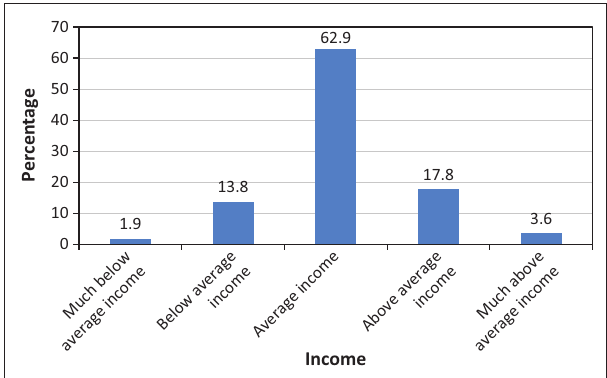
FIGURE 1: Percentage of individuals covered by health insurance by income classifications. TABLE 2: Household expenditure characteristics mean in the last 30 days. Quintile group Mean of amount spent on health Mean of amount spent on medical Mean of amount spent on hospital insurance (ZAR) professionals (ZAR) fees